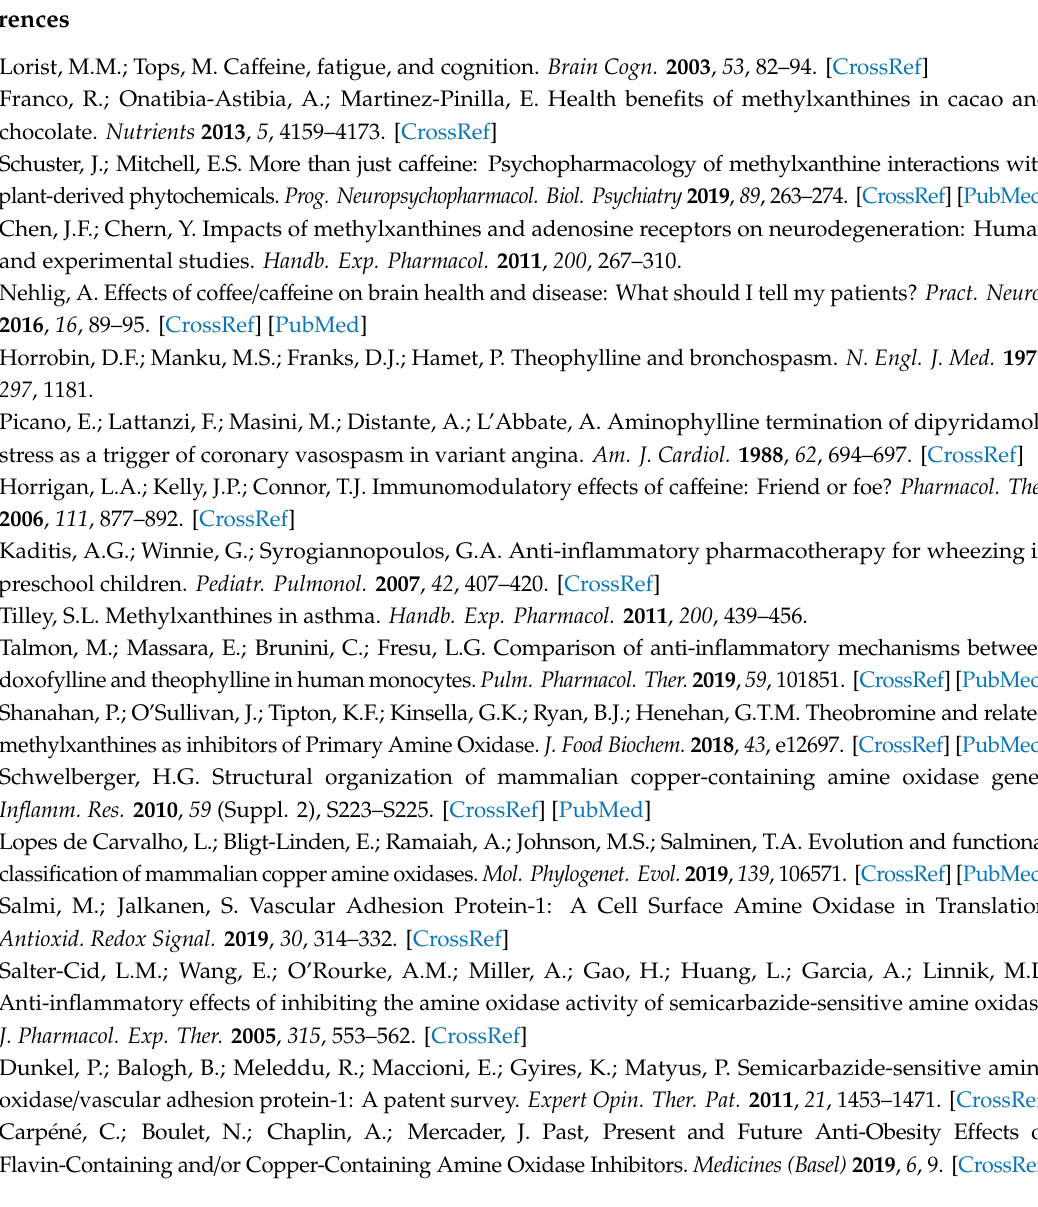
Figure S1: Chemical structures of the methylxanthines used in this study. Only 3-isobutyl-1-methylxanthine (IBMX) is not a naturally occurring N-methylated derivative of xanthine, Figure S2: Interferences between Amplex Red-based fluorescent detection of hydrogen peroxide and amine oxidase substrates or inhibitors of reference (S2a); vehicles (S2b); methylxanthines (S2c); and polyphenols (S2d), Figure S3: Michaelis-Menten data of benzylamine and tyramine oxidation by human adipose tissue